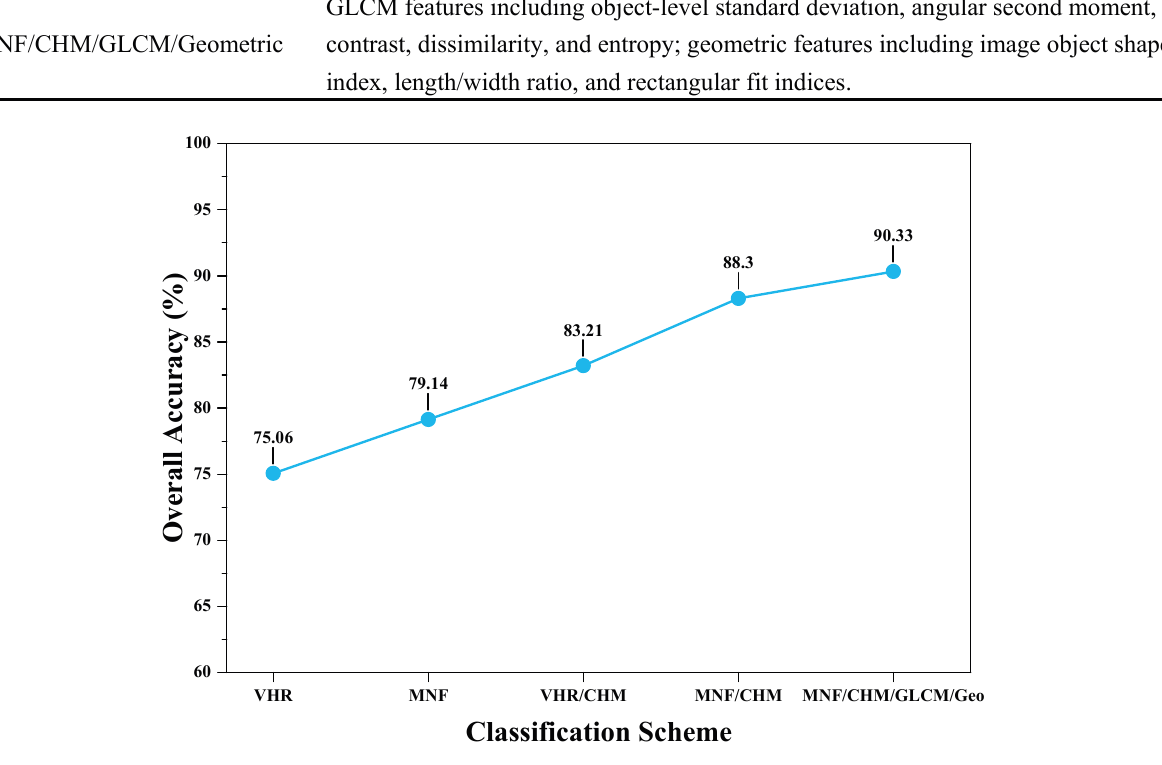
Figure 13. Overall classification accuracies of different data